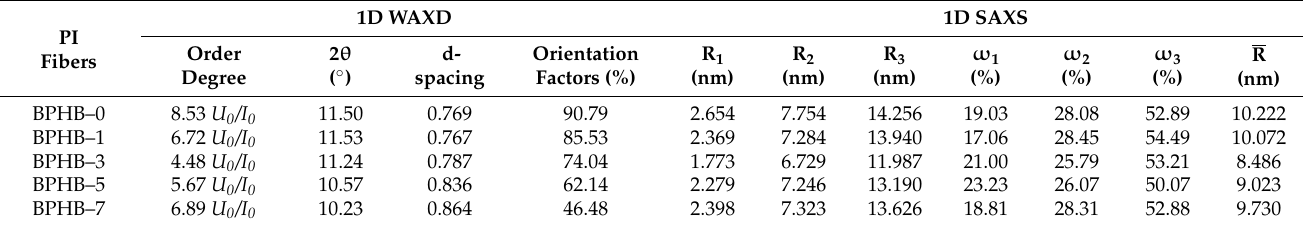
Table 3. 1D WAXD and 1D SAXS results of PI fibers with various molar ratios of